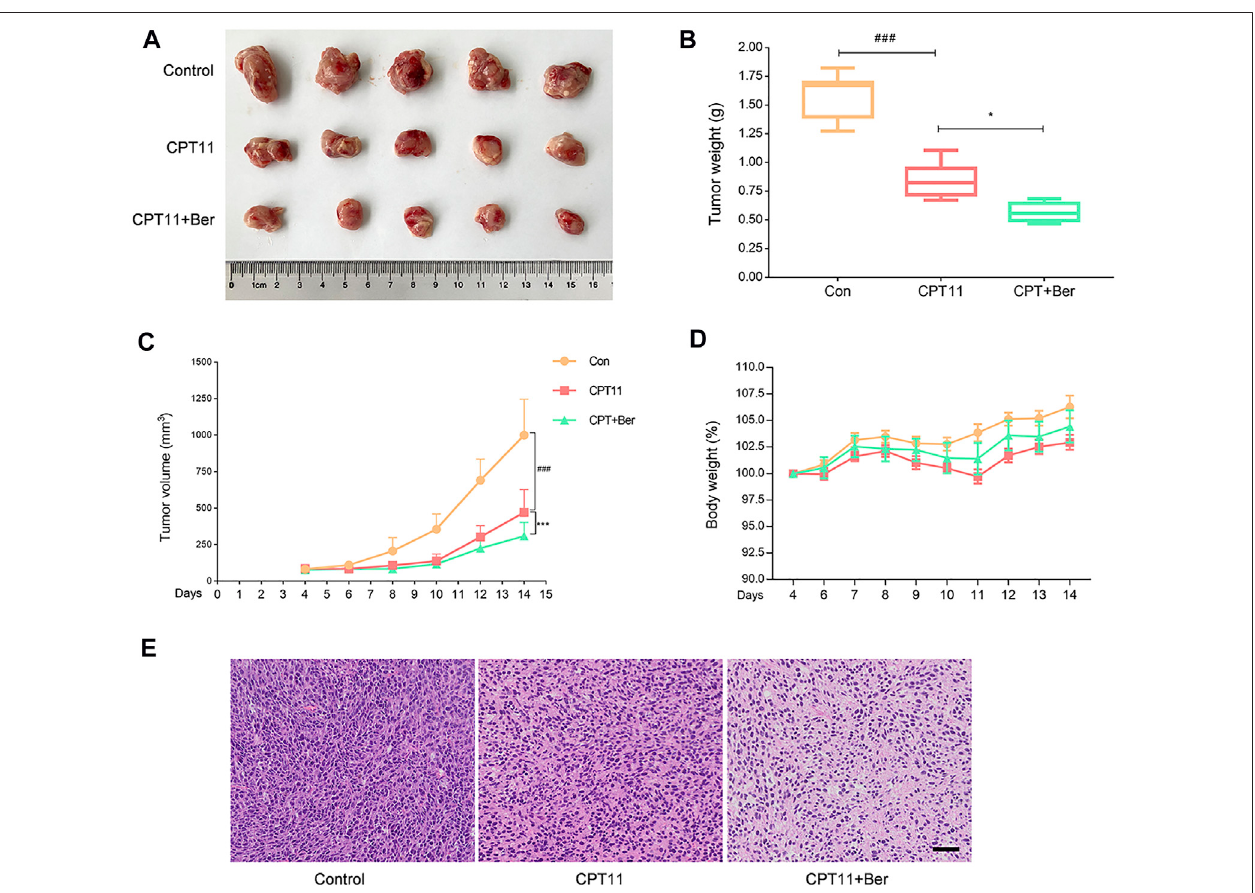
FIGURE 7 | Berberine (50 mg/kg) improved the anti-tumor effects of CPT11 in a colon cancer xenograft model. (A) Image of colorectal tumor in each group. (B) Tumor weights were measured after animals were euthanized. (C) Tumor volumes were measured during the test period. (D) Changes in body weight were monitored throughoutthestudy. (E) Imagesofhematoxylinandeosinstainingintumortissues.Dataareexpressedasthemean ± SD( n (cid:2) 5pergroup).### p < 0.001 vs. thecontrol group; *** p < 0.001 vs. CPT11 + berberine treated group.